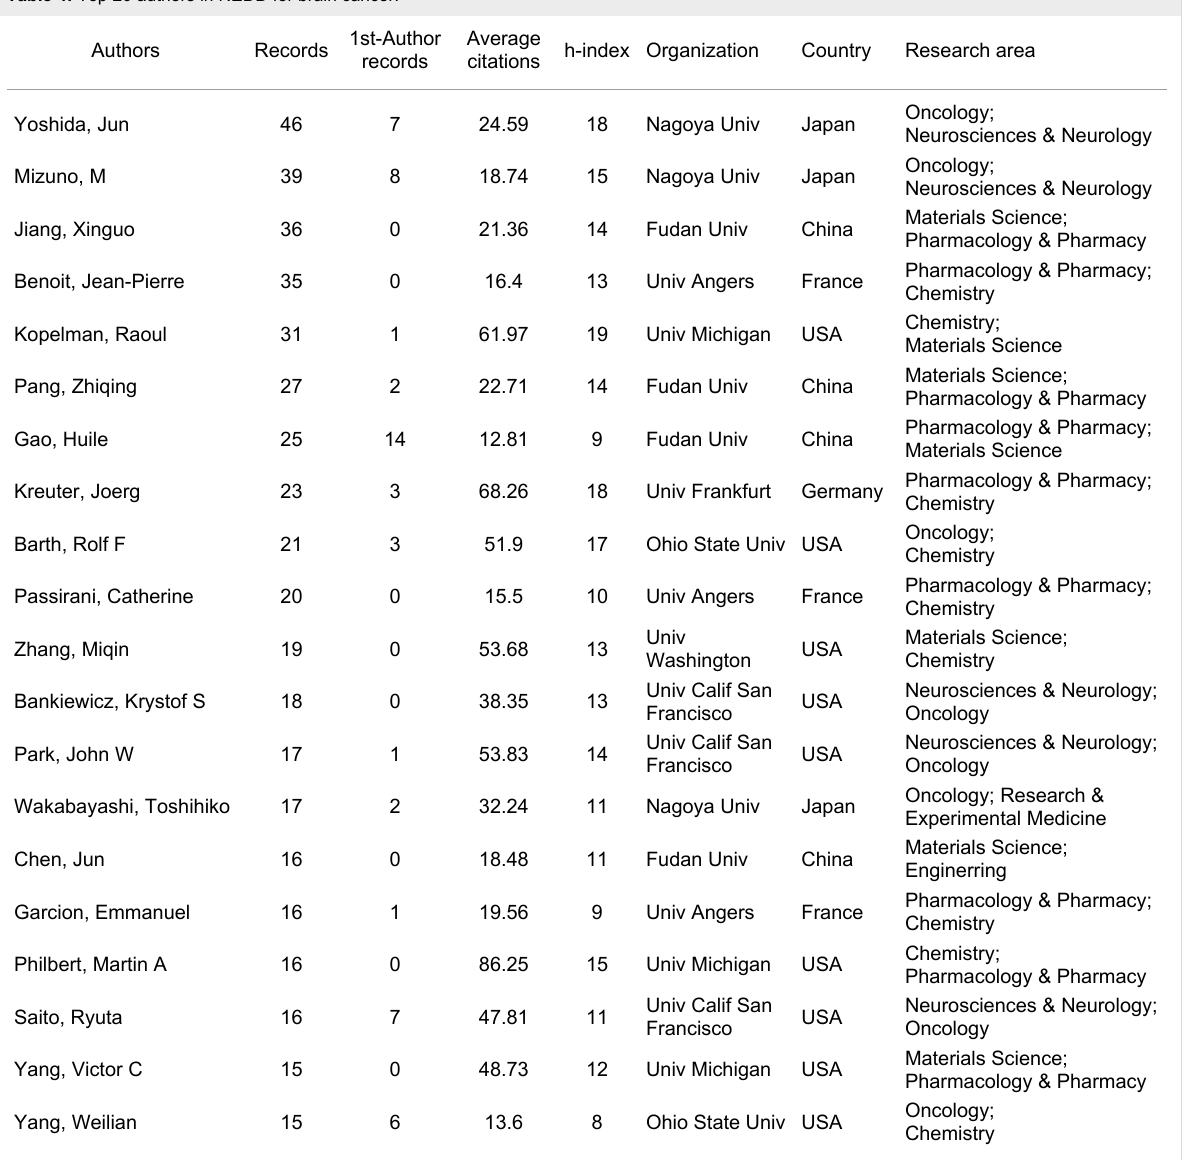
Table 4: Top 20 authors in NEDD for brain